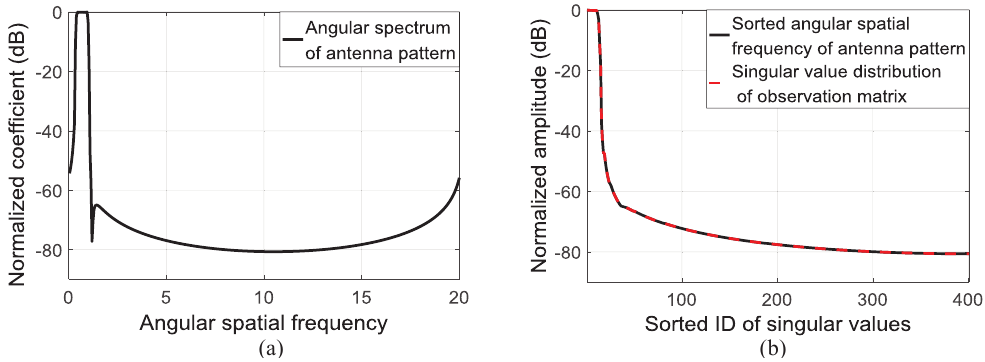
Figure 2. Illustration of singular values and Fourier transform